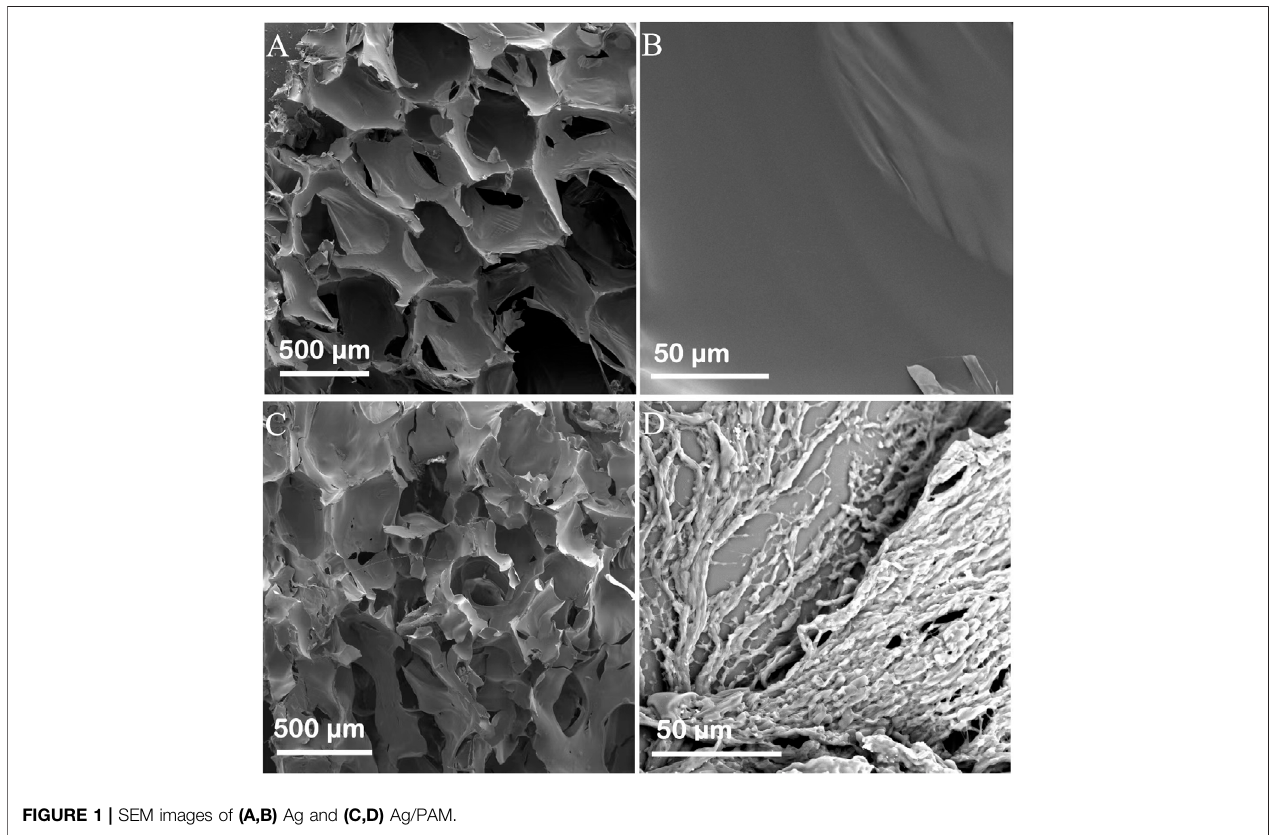
FIGURE 1 | SEM images of (A,B) Ag and (C,D) Ag/PAM.